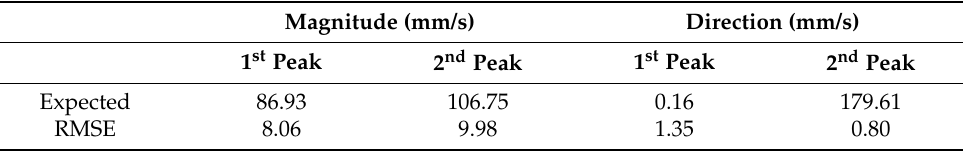
Table 3. Summary of mean value and RMSEs in magnitude and direction from the validation result in PIV measurement. Note that time-averaged data are used to generate these values, and mean magnitude and direction are estimated from case PIVR (corresponding to 1st peak) and case PIVG (corresponding to 2nd